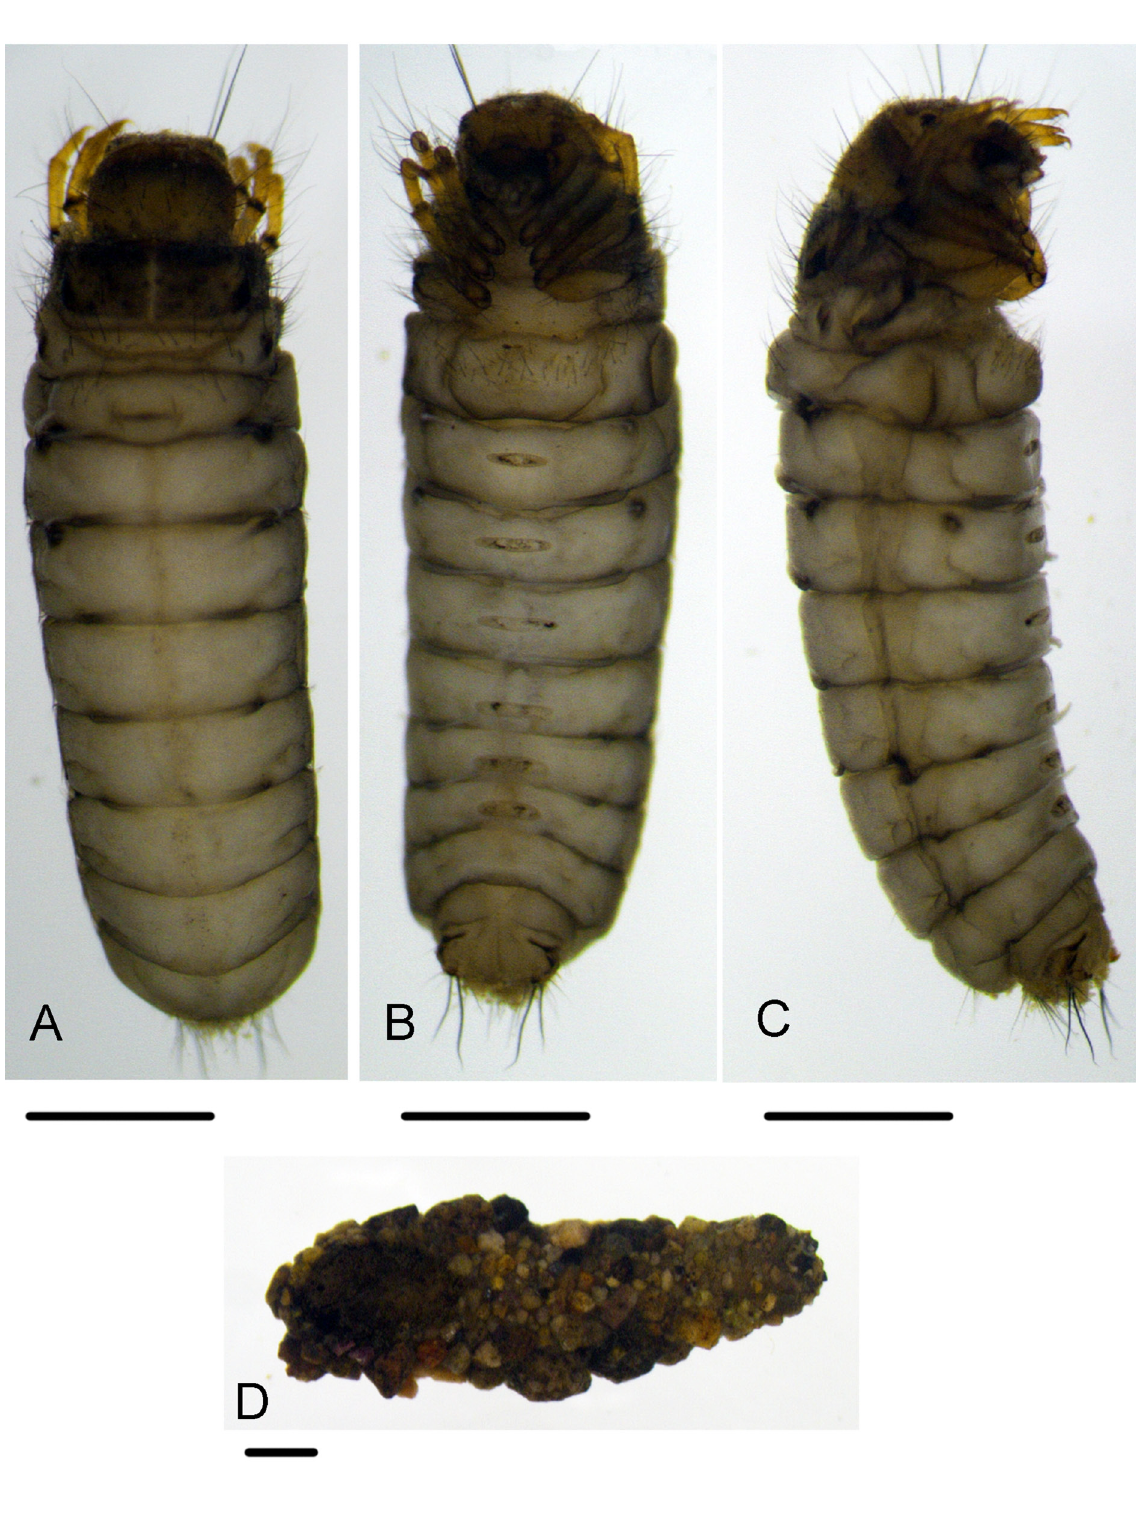
Fig. 13. Habitus of Apatidelia acuminata Leng & Yang, 1998, larva. A . Dorsal view. B . Ventral view. C . Lateral view. D . Case (ventral view). Scale bars = 1.0